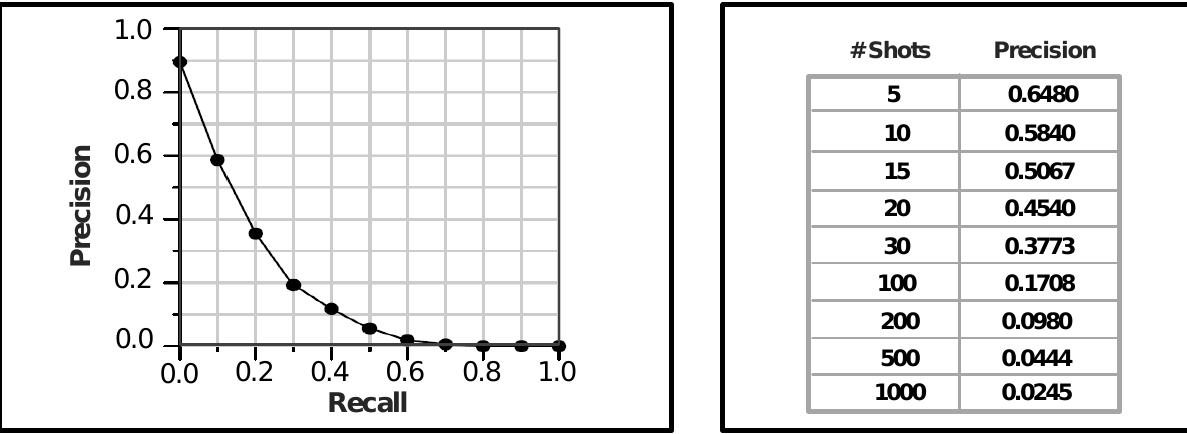
Figure 15. Interpolated recall-precision curve (left) and precision at n shots